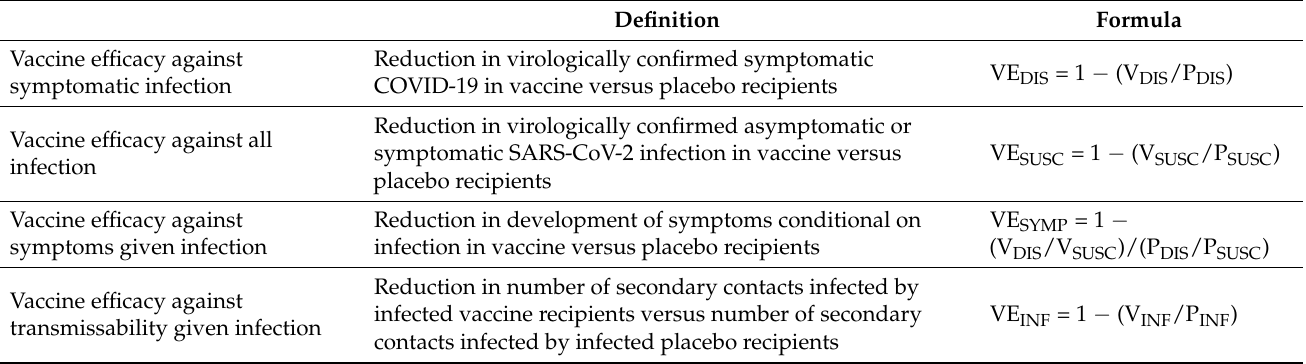
Table 1. Vaccine efficacy